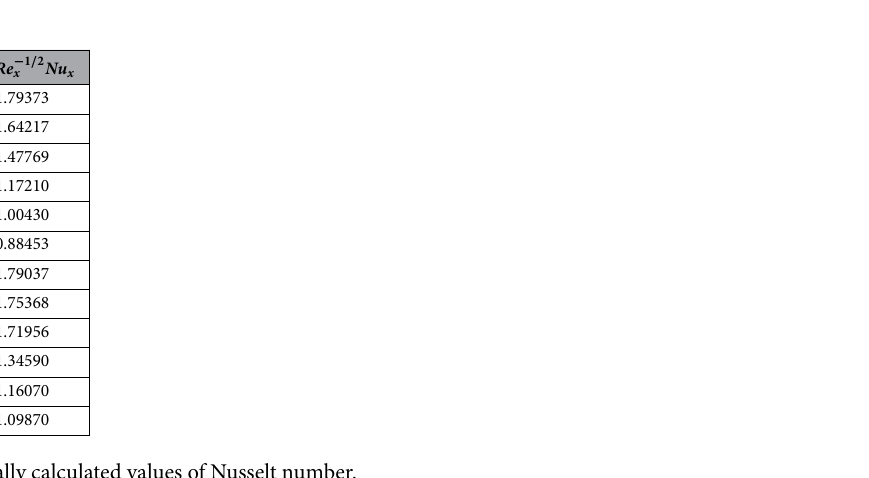
Figure 17. N G (η) for versus estimates of B r .